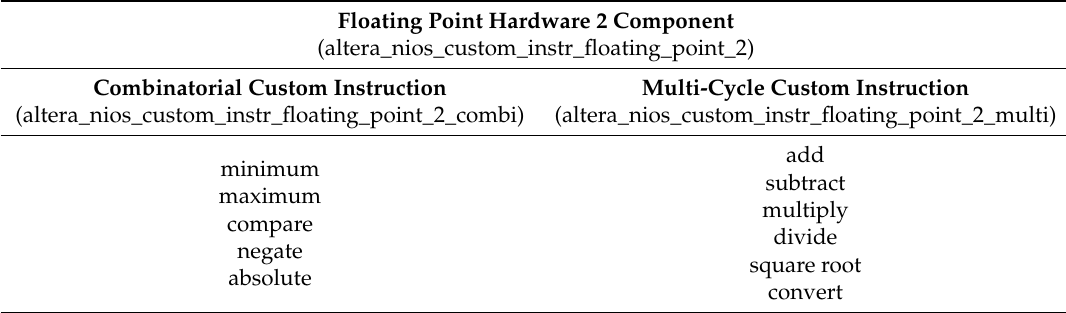
Table 3. Floating operations implemented by each custom